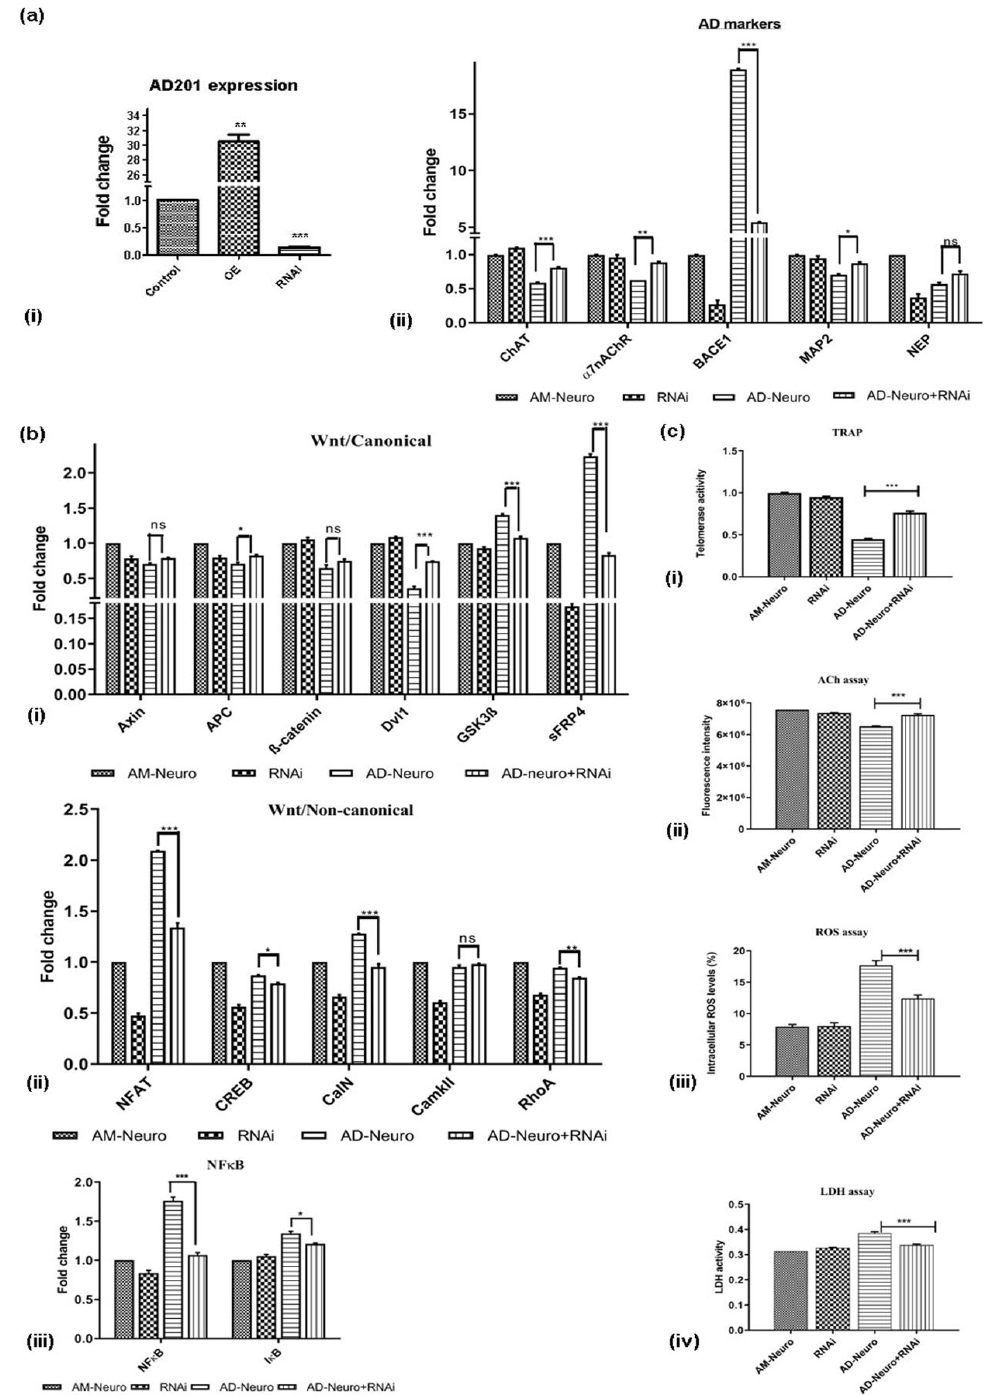
Figure 7. RNAi-mediated downregulation of Wnt antagonist, AD201 reverse neurodegeneration in in vitro AD model. ( a ) ( i ) qRT-PCR analysis showing AD201 expression in AD201-overexpressed (OE) and downregulated cells (RNAi), ( ii ) expression of AD-associated markers; ChAT, α 7nAChR, BACE1, MAP2 and NEP by qRT-PCR analysis. ( b ) Gene expression analysis by qRT-PCR for ( i ) Wnt/canonical pathway markers: Axin, APC, ß-catenin, Dvl1, GSK3ß and sFRP4, ( ii ) Wnt/non-canonical pathway markers: NFAT, CREB, CalN, CaMKII and RhoA, ( iii ) NF κ B and I κ B. Data are represented as mean with SEM ( n = 3), * p < 0.05, ** p < 0.01 *** p < 0.001. ( c ) Graphs showing ( i ) increase in telomerase activity, ( ii ) increase in ACh levels, ( iii ) decrease in intracellular ROS and ( iv ) decrease in LDH activity upon downregulation of AD201 in AD-Neuro cells. Data are represented as mean with SEM ( n = 3), *** p <